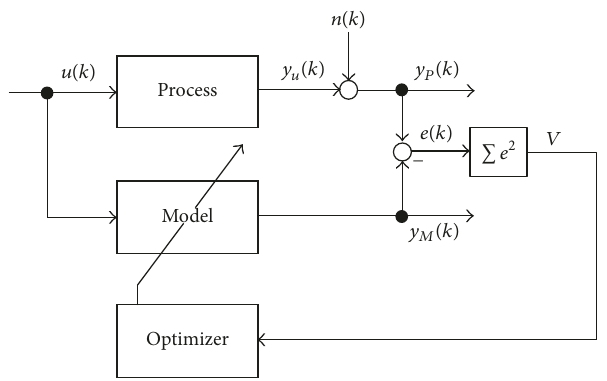
Figure 7: Schematic diagram of identification arrangement